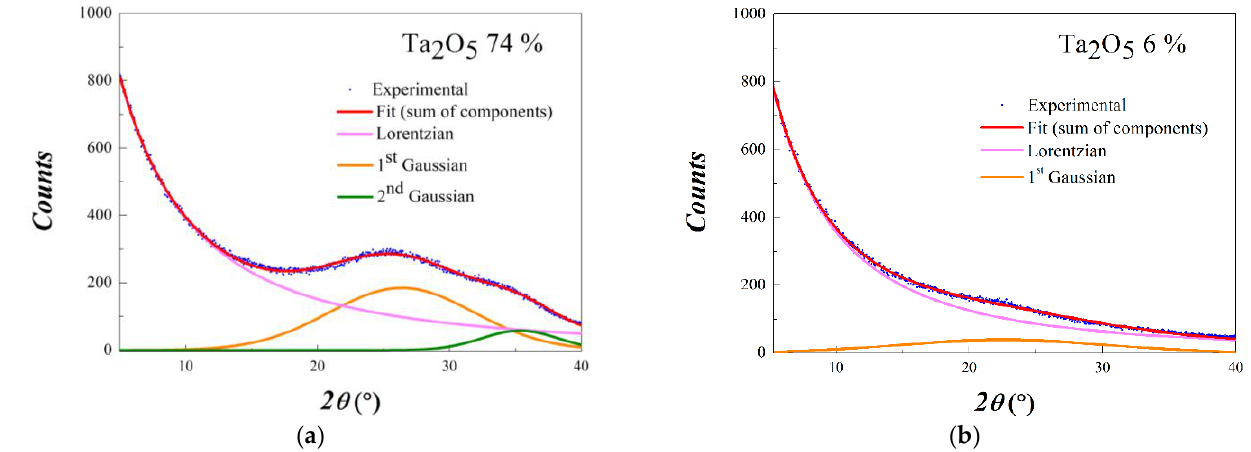
Figure 3. ( a ) Best-fit of GIXRD curve obtained for the sample with 74% Ta 2 O 5 and 26% SiO 2 ; ( b ) best- fit of GIXRD curve obtained for the sample with 6% Ta 2 O 5 and 94% SiO 2 . Both curves were obtained by employing 0.6 mm slit widths for input and output beams. Experimental data are indicated by the blue dots, whereas the best-fit curve is the red line.